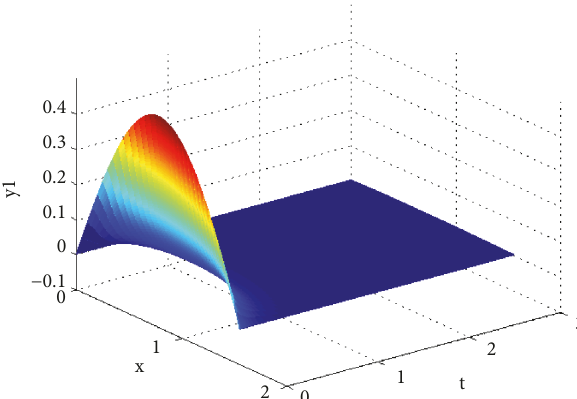
Figure 9: The closed-loop trajectory of 𝑦 1 (𝑥,𝑡) .